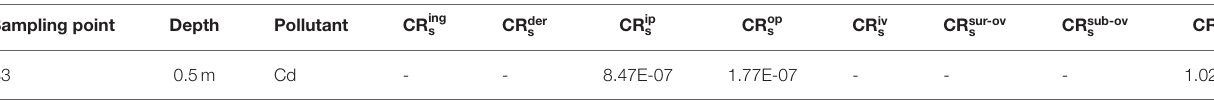
TABLE 1 | Soil risk results under the condition of reutilization (carcinogenic risk). Sampling point